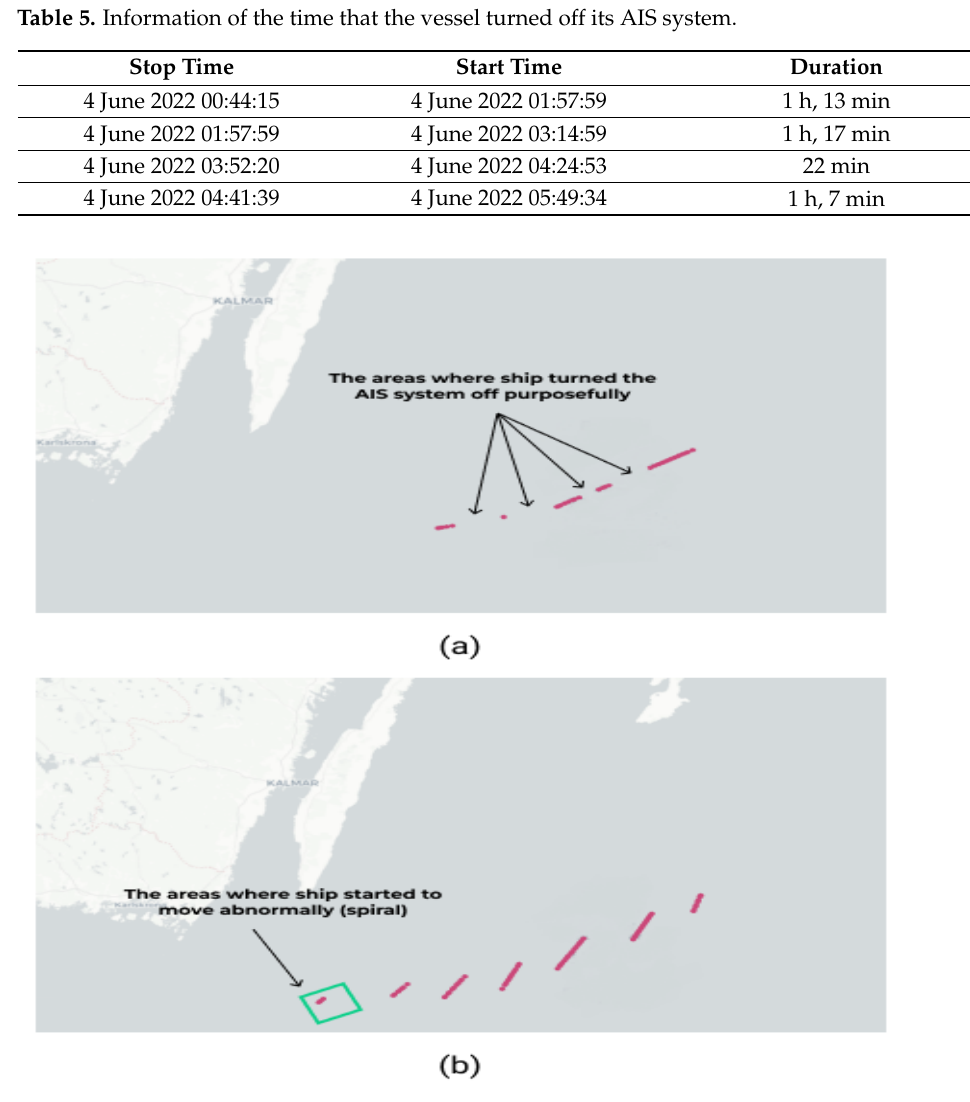
Figure 26. ( a ) The tug ship turns off the AIS system and crews do not transmit any AIS messages. ( b ) Spiral movements of the cargo ship are